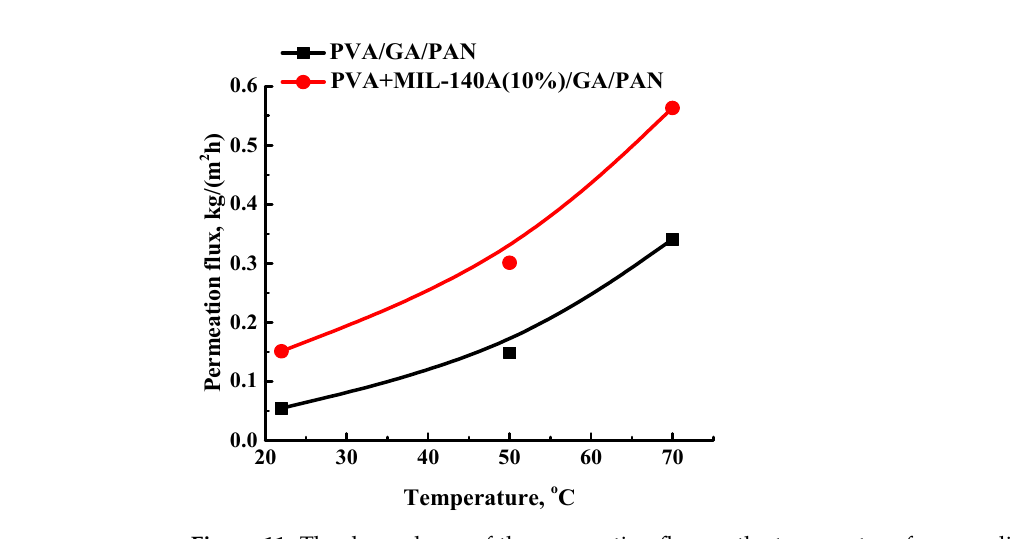
Figure 11. The dependence of the permeation flux on the temperature for cross-linked composite PVA/GA/PAN and PVA+MIL-140A(10%)/GA/PAN membranes in pervaporation separation of water/isopropanol mixture (12 wt% water). Water content in the permeate for PVA/GA/PAN and PVA+MIL-140A(10%)/GA/PAN membranes was 99.9 wt%. It was found that with an increase in temperature, the permeation flux increased, which could be caused by the increase of the free volume in the matrix by increasing the movement of PVA chain segments [81]. The PVA+MIL-140A(10%)/GA/PAN mem- brane has a higher permeation flux at all temperatures tested, compared to the unmodi- fied PVA/GA/PAN membrane because of the increased surface roughness, the changes of surface hydrophilic-hydrophobic membrane surface balance and interfacial defects or gaps [64]. The PVA+MIL-140A(10%)/GA/PAN membrane had a permeation flux of 0.563 kg/(m 2 h) and water content in permeate of 99.9 wt% in pervaporation separation of water/isopropanol mixtures (12 wt% water) at 70 °C.